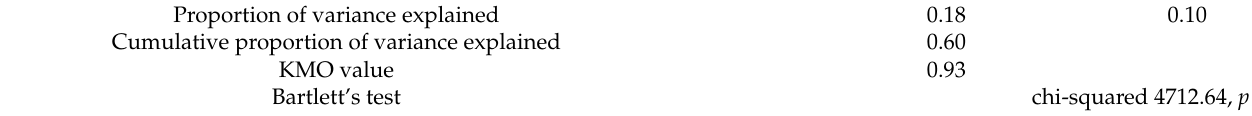
Factor II Social Withdrawal